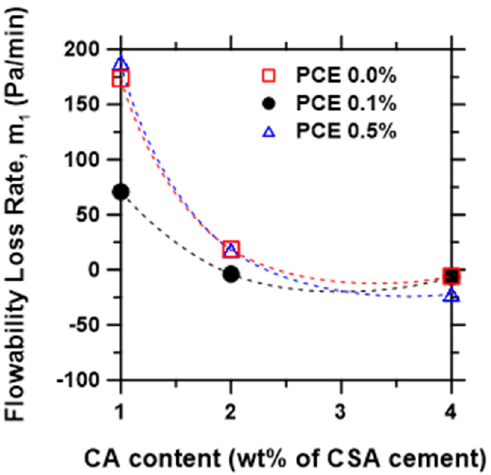
Figure 4. Rate of loss of flowability, 𝒎 𝟏 , of CSA cement mixtures as a function of admixture dos-